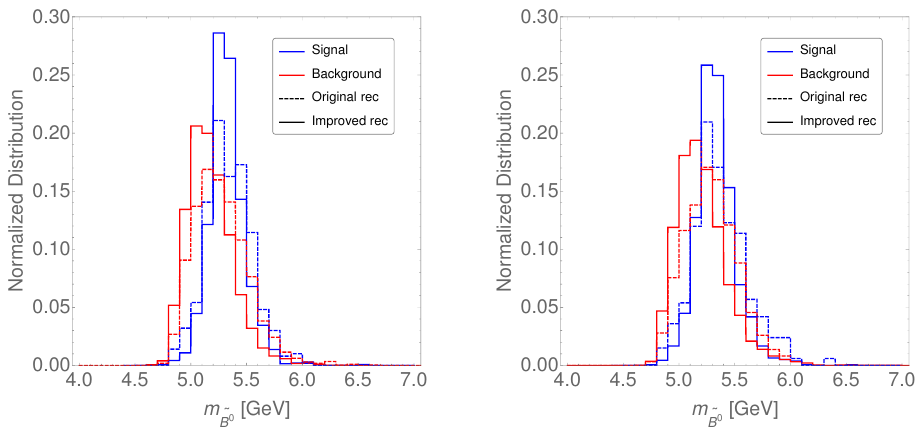
Figure 8 . Normalized distributions of the reconstructed B -meson mass for the B 0 → K ∗ 0 τ + τ − measurement before cuts 1-3 are applied. Here the spatial resolution for the tracker is assumed to be 5 µ m (left) and 10 µ m (right). The dashed and solid curves are based on the reconstruction scheme developed for an ideal tracker (see section 2) and the one improved for a tracker with finite spatial resolution (see footnote